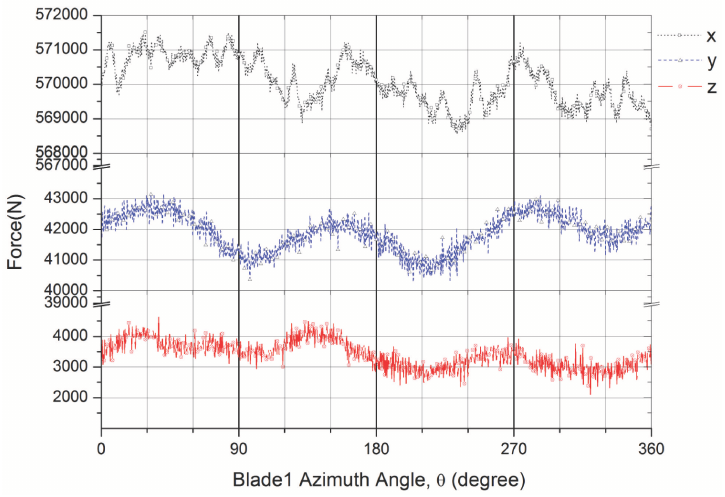
Figure 5. The force imposed on the turbine body in the x -, y - and z -axis